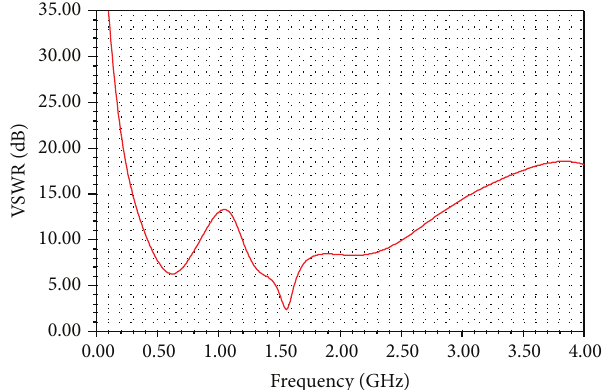
Figure 6: VSWR of the printed Z-shaped antenna on glossy paper.